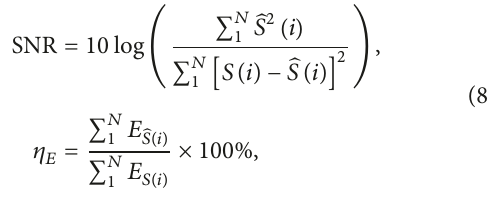
noise frequency and the effective wave frequency is effectively